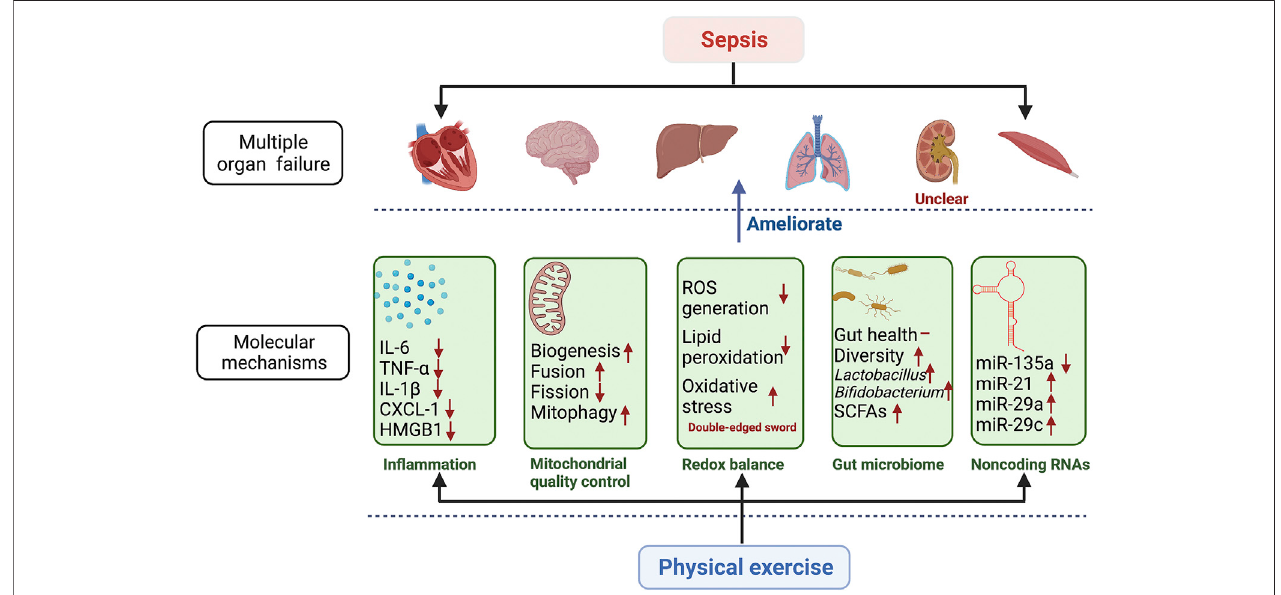
FIGURE2| Molecularmechanisms involved inthe bene fi cial effects ofphysicalexerciseon multiple organ failure insepsis.The fi gure showshow physical exercise regulatesmultiple organ failure through these potentialmolecularmechanisms. The potentialmolecular mechanisms include in fl ammation, mitochondrial quality control, redox balance, gut microbiome, and noncoding RNAs. These potential molecular mechanisms regulated by physical exercise ameliorate sepsis-induced multiple organ failure, including respiratory, cardiovascular, neurological, hepatic, hematological, and muscle systems. The effects of physical exercise on renal dysfunction are unclear in sepsis. IL-6 interferon 6; TNF- α tumor necrosis factor α ; IL-1 β interferon 1 β ; CXCL-1 chemokine (C-X-C motif) ligand 1; HMGB1 high mobility group 1; ROS reactive oxygen species; SCFAs short-chain fatty acids; miR-135a microRNA 135a; miR-21 microRNA 21; miR-29a microRNA 29a; miR-29c microRNA